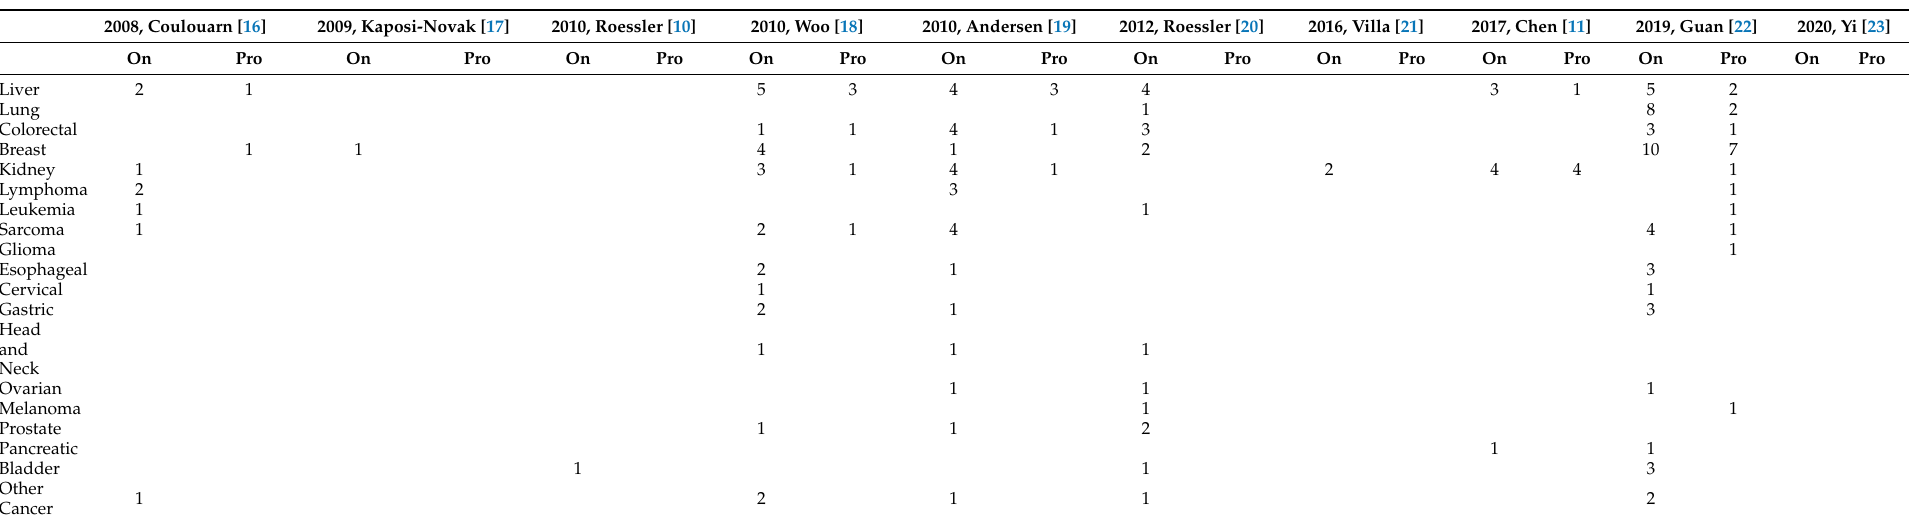
Table 2. ProfileChaser and Oncomine results of HCC gene